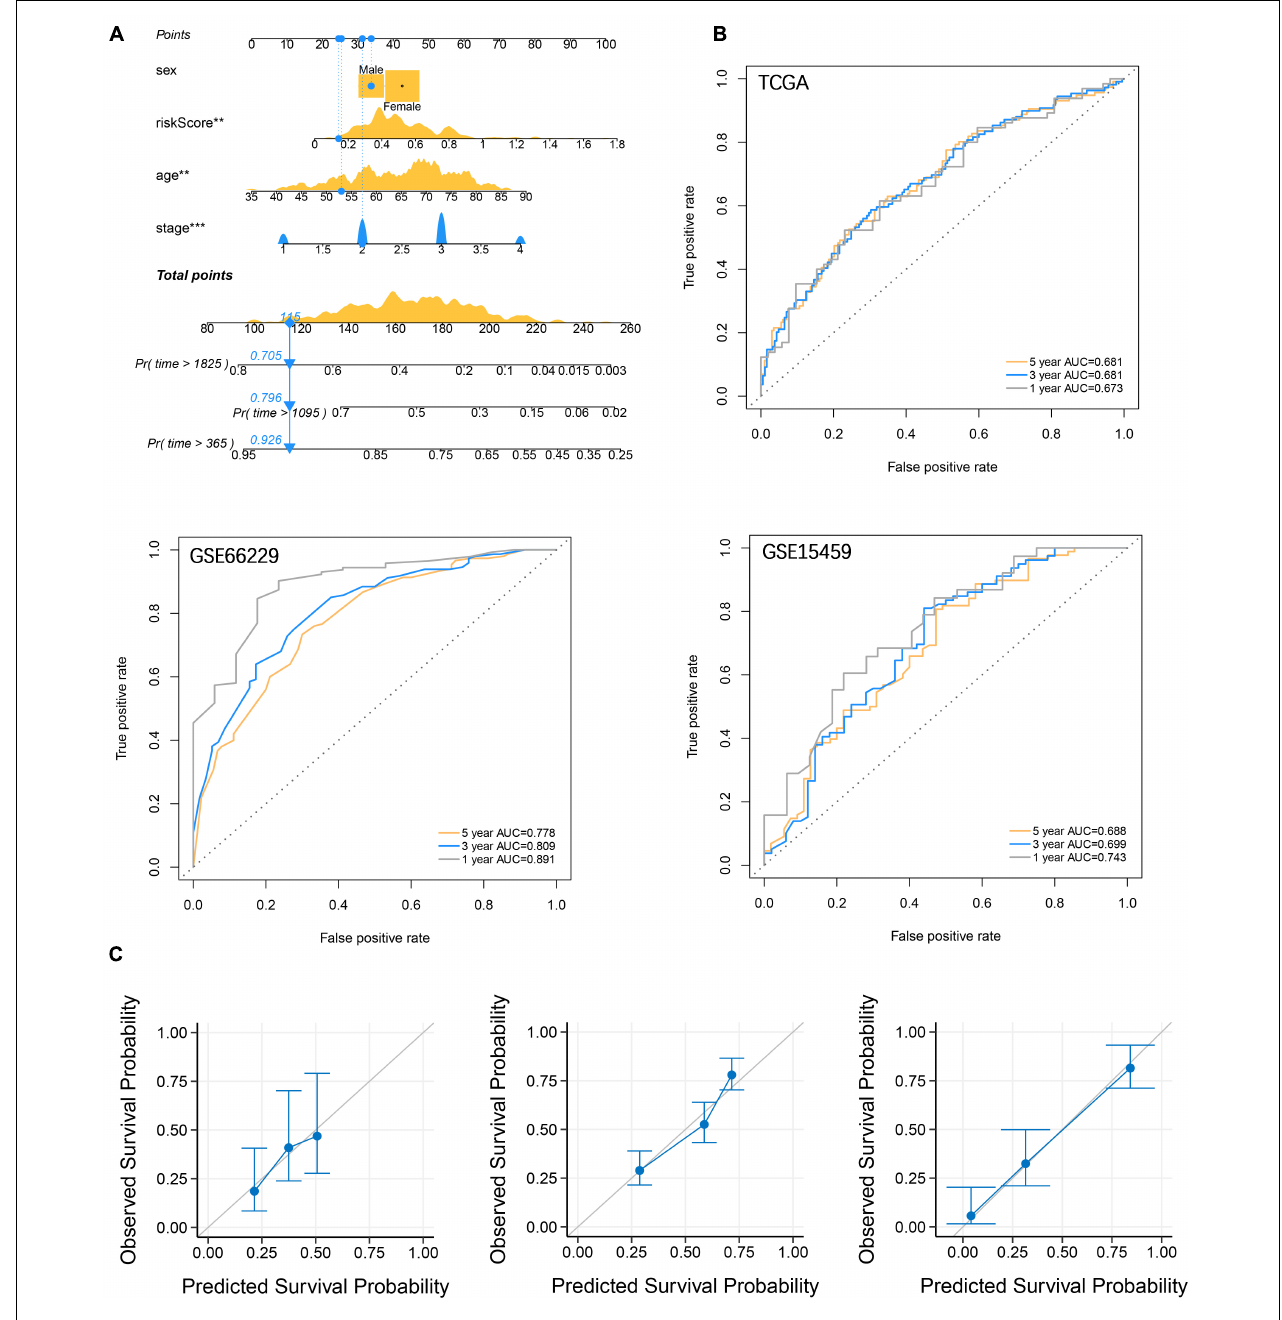
FIGURE 8 | Establishment and verification of nomograms. (A) Riskscore and clinicopathological characteristics were used to construct nomograms (B) The ROC curve describes the efficiency of the nomogram for predicting the overall survival of GC 1, 3, and 5 years. (C) Calibration curves were used to evaluate the accuracy of nomograms in predicting the 5-year overall survival of GC